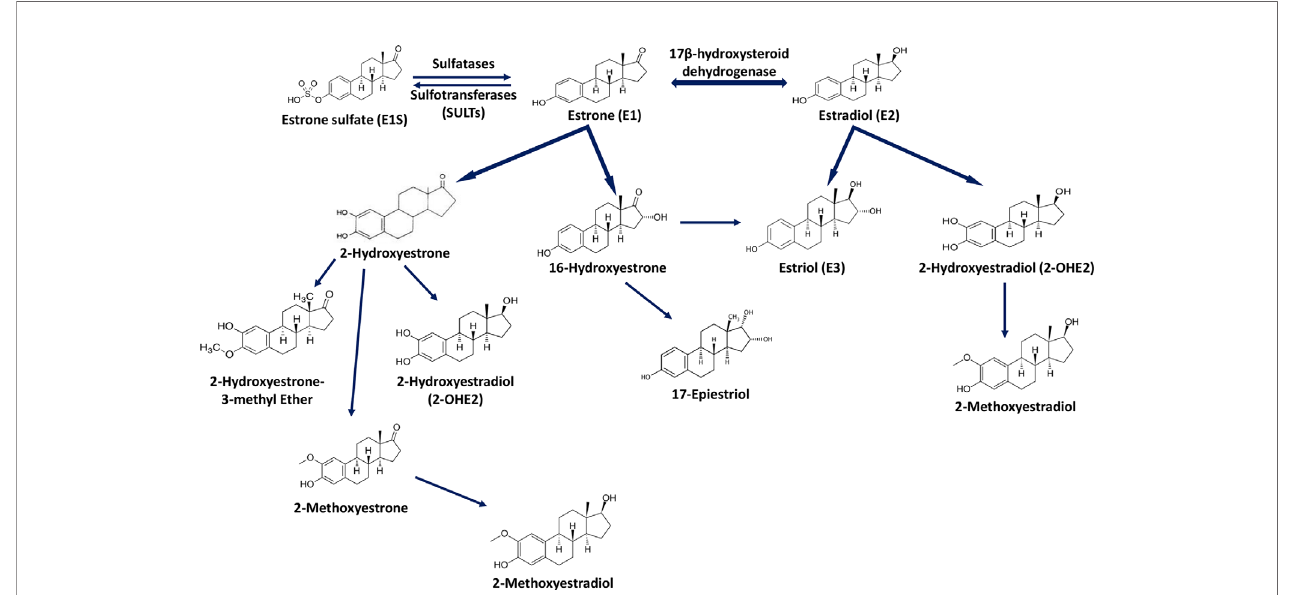
FIGURE 2 | Estrogen metabolism. This schematic identi fi es key intermediates in the metabolism of estrone and